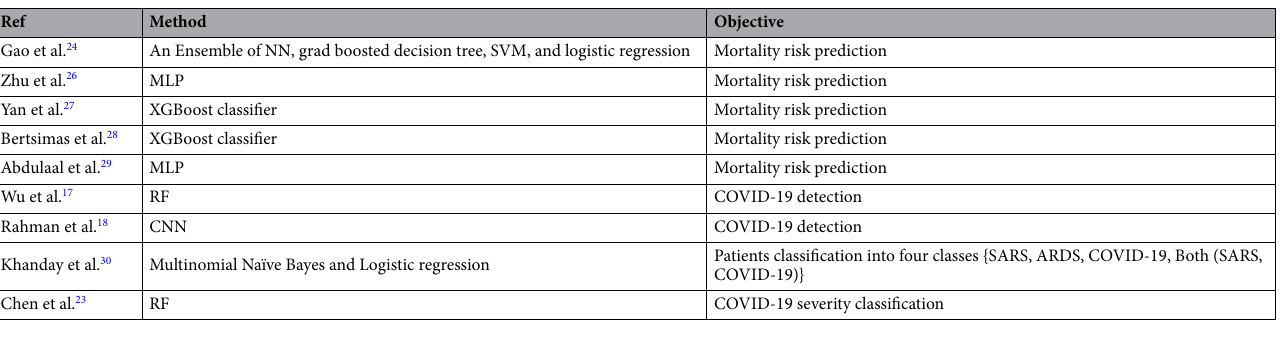
Table 1. Summary of the reviewed